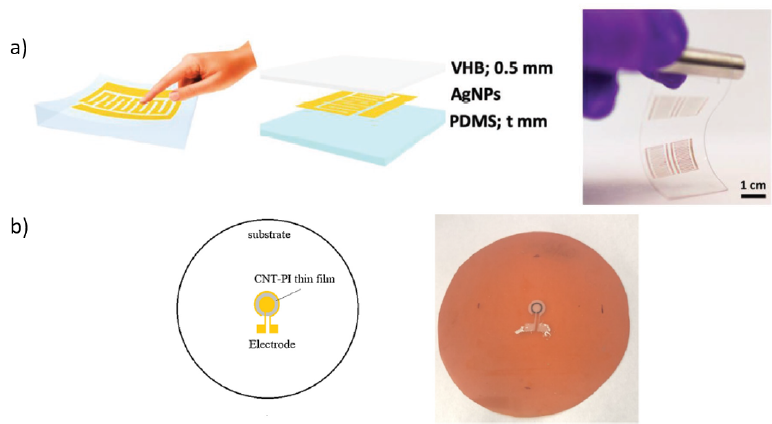
Figure 5. Schematic illustrations of printed piezoresistive sensors: ( a ) [139] and ( b )